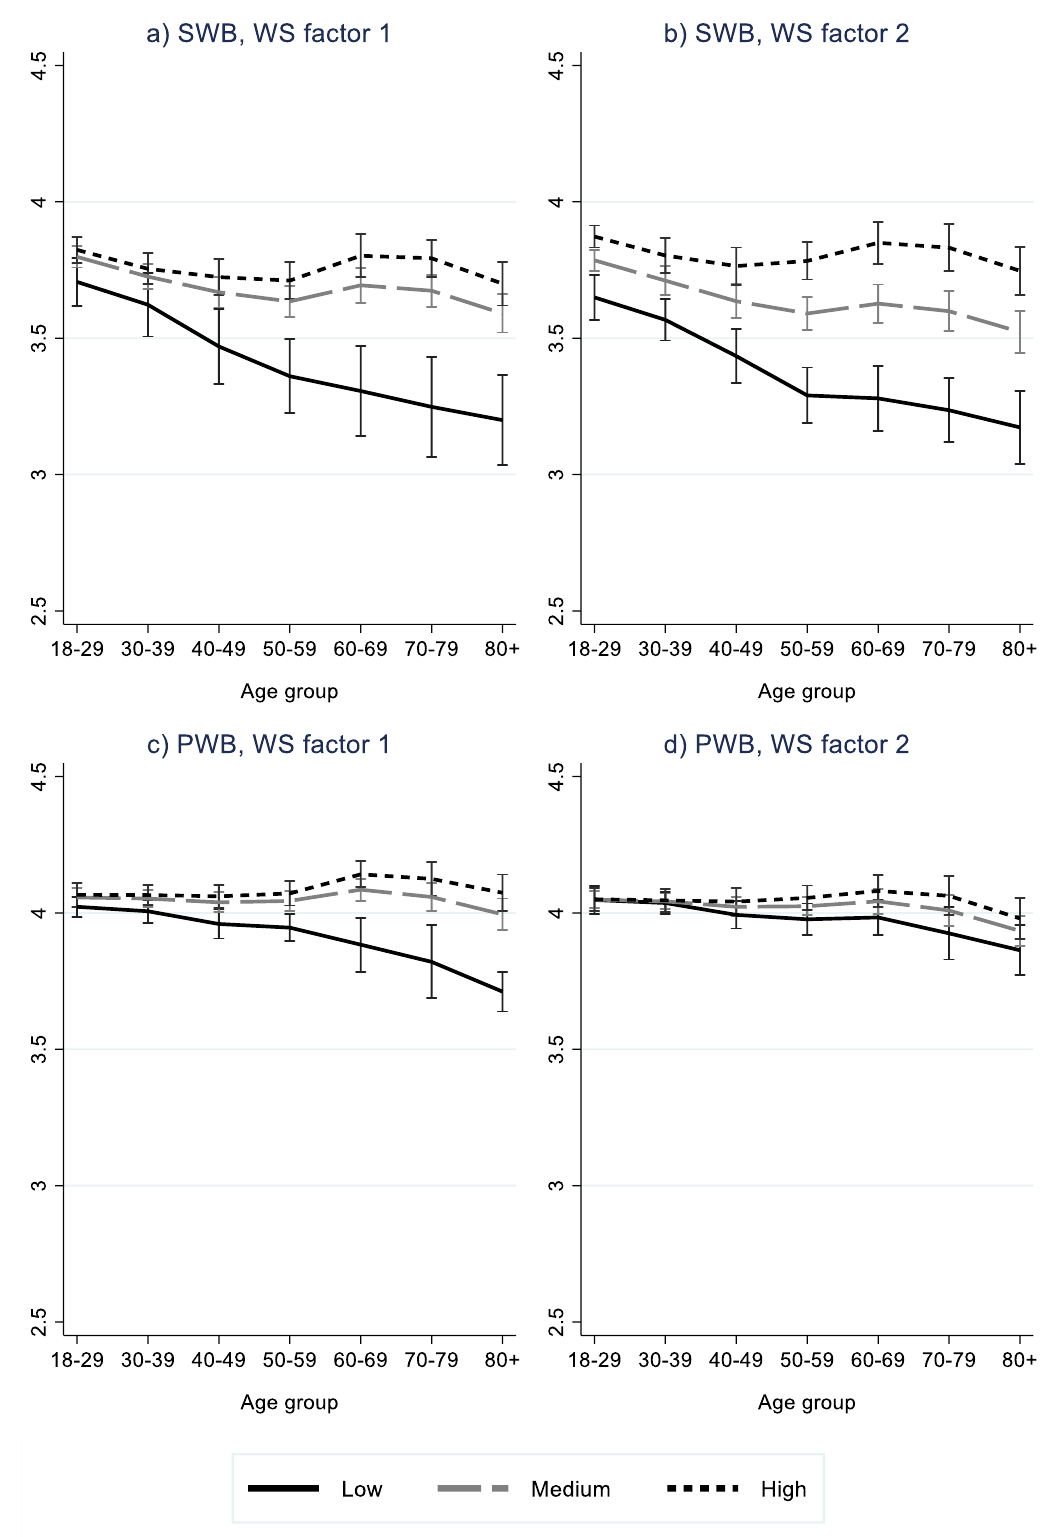
Figure 4. Predicted level of subjective wellbeing ( a , b ) and psychological wellbeing ( c , d ) by age and high (p90), medium (p50) and low (p10) values of WS Factor 1 ( a , c ) and WS Factor 2 ( b , d ). Results from multi-level regression (Model 2). NB Scale in Figure 2.5 – 4.5.